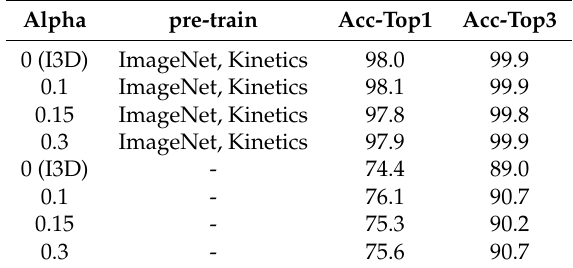
Table 1. Experimental result of changing alpha value on UCF-101.